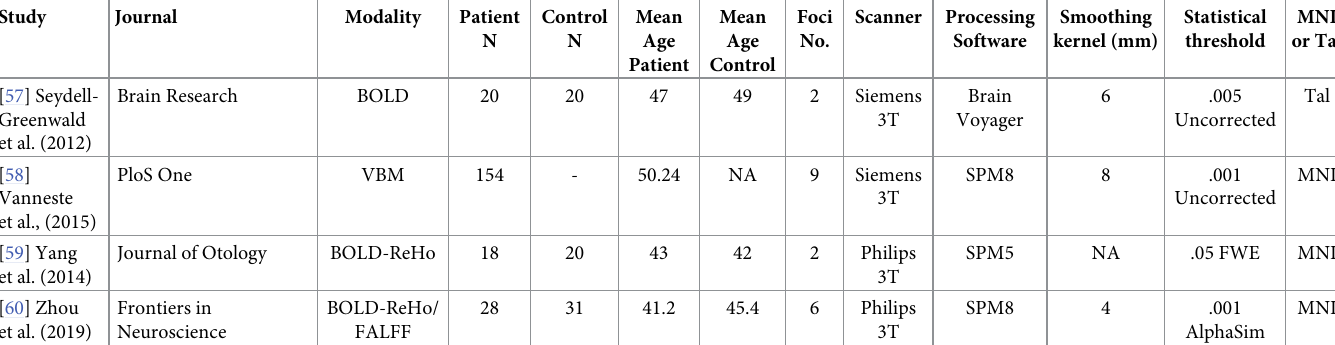
The current findings represent the disease effects of tinnitus in grey matter, glucose metabo- lism, and blood flow. Two ALEs were implemented with different levels of statistical rigor: cor- rected for multiple comparisons and uncorrected. The cluster-level inference ALE with family-wise error (FWE) rate was more stringent and demonstrated one cluster with five regions related to the disease effects of tinnitus. These regions included the posterior cingulate gyrus/precuneus and cingulate gyrus. Moreover, these regions remained significant in relation to tinnitus disease-effects after introducing 6% added noise, which accounts for negative